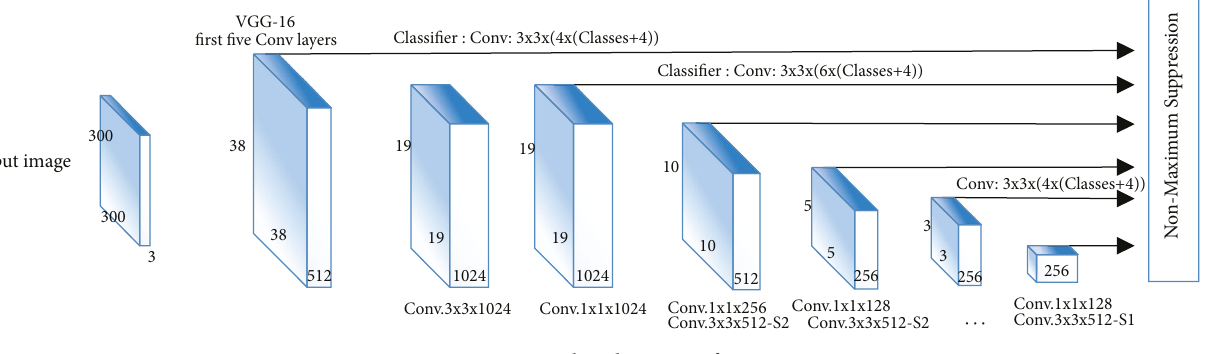
Figure 4: Network architecture of SSD.